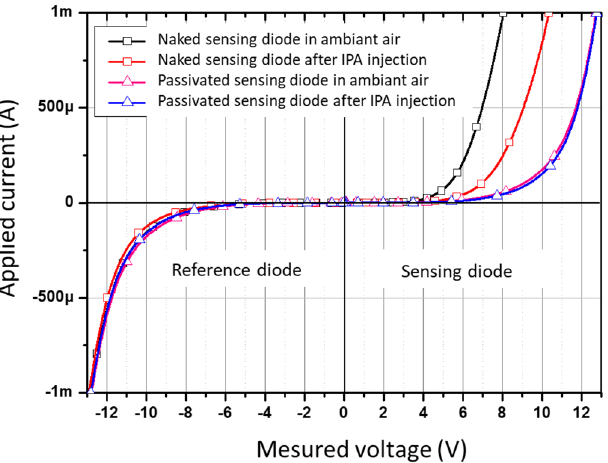
Figure 9. Characterization of two sets of diodes with and without passivation under ambient air and isopropanol vapors.